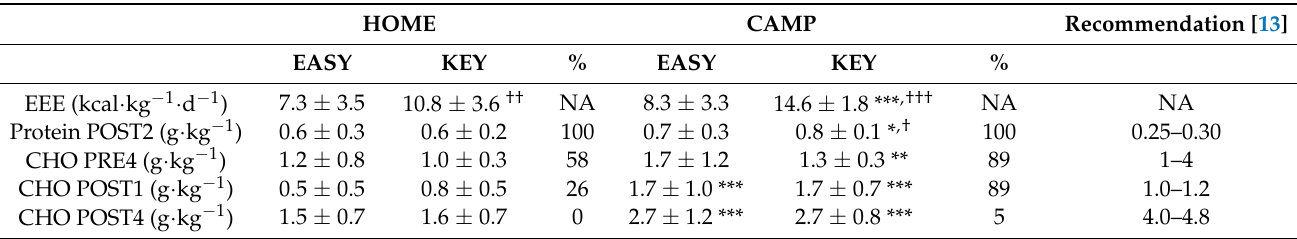
Table 2. Mean ( ± SD) daily training volume, energy and macronutrient intake, exercise energy expenditure, and energy availability in young female cross-country skiers (n =